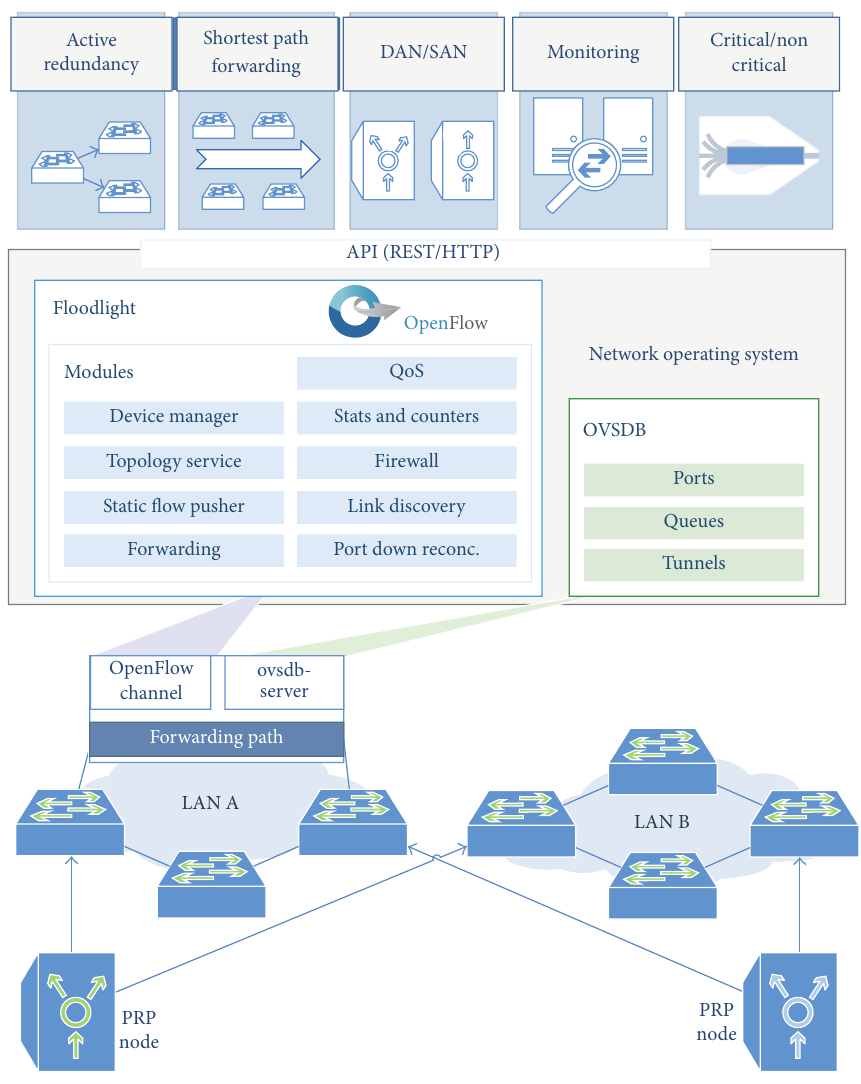
Figure 3: Proposed architecture: NOS and